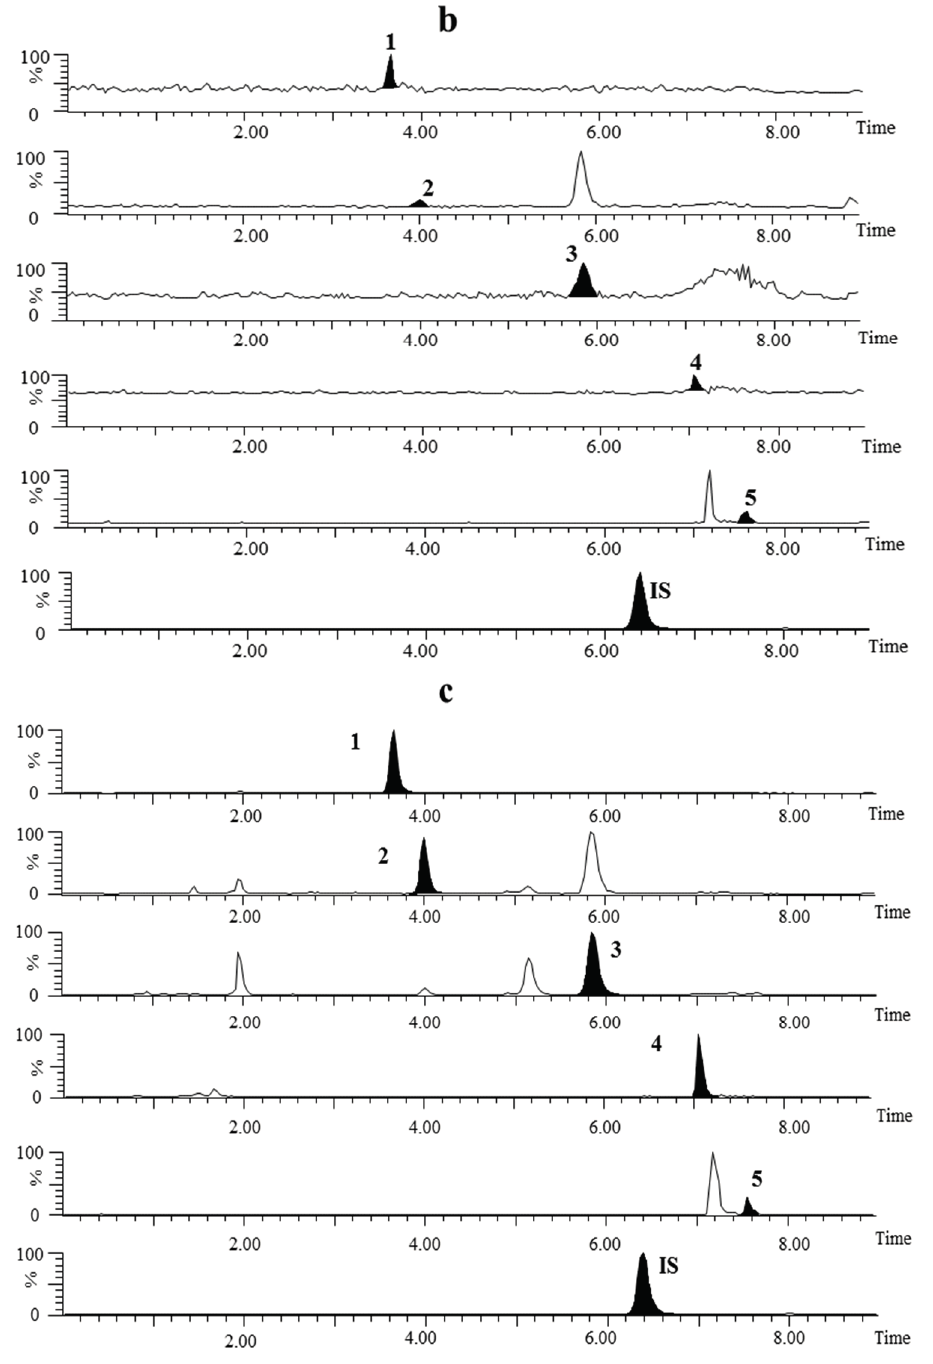
Figure 6. MRM chromatograms of each component in ( a ) blank plasma; ( b ) blank plasma spiked with a solution of standard mixture at the LLOQ; ( c ) plasma sample at 30 min after oral XEO/ β -CD inclusion complex. Component ideitification: (1) senkyunolide A; (2) 3- n -butylphthalide; (3) Z -ligustilide; (4) dehydrocostus lactone; (5) α -cyperone; IS